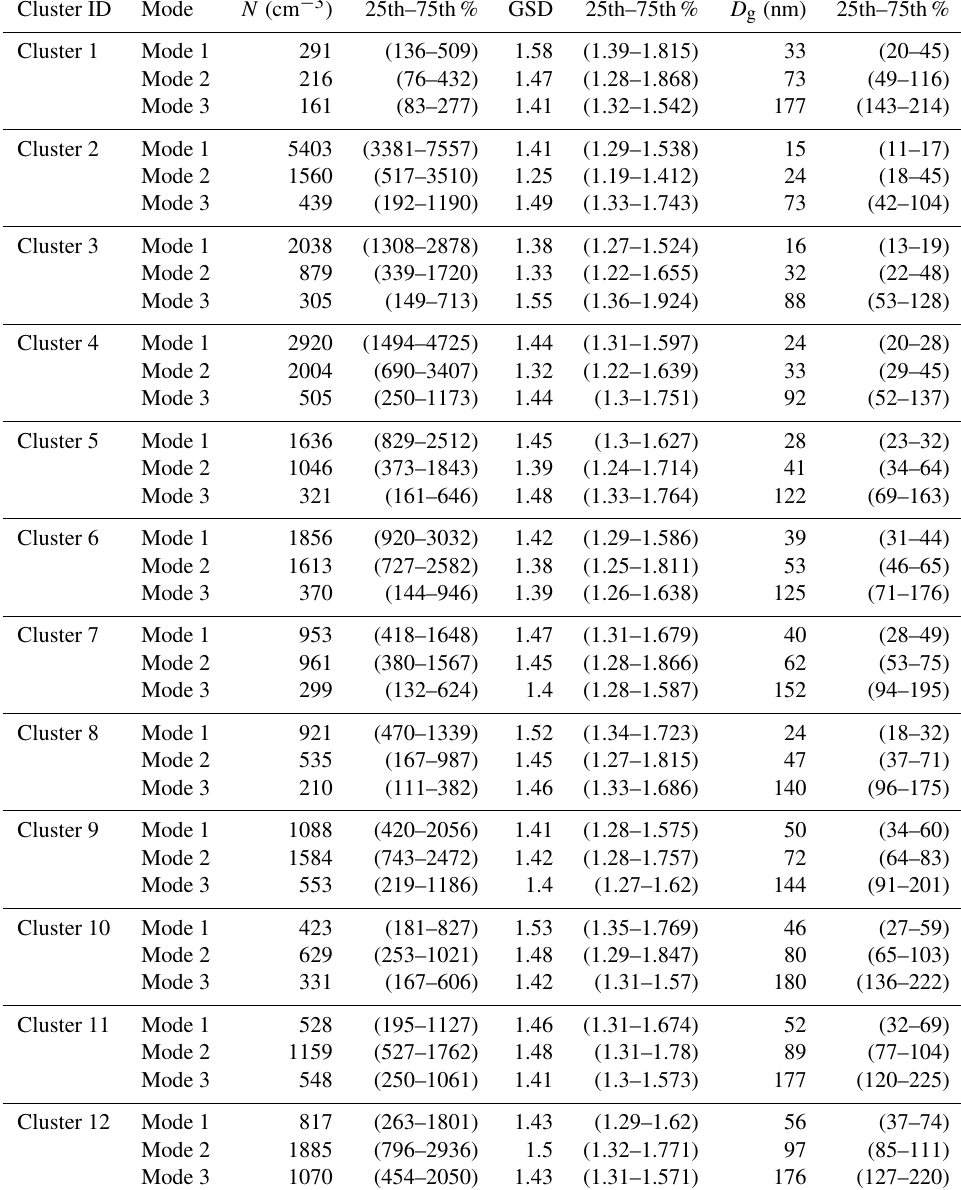
Table 2. Fitted modal parameters per cluster shown in Fig. 2. GSD represents the geometric standard deviation and D g the geometric mean diameter of each of the log-normal